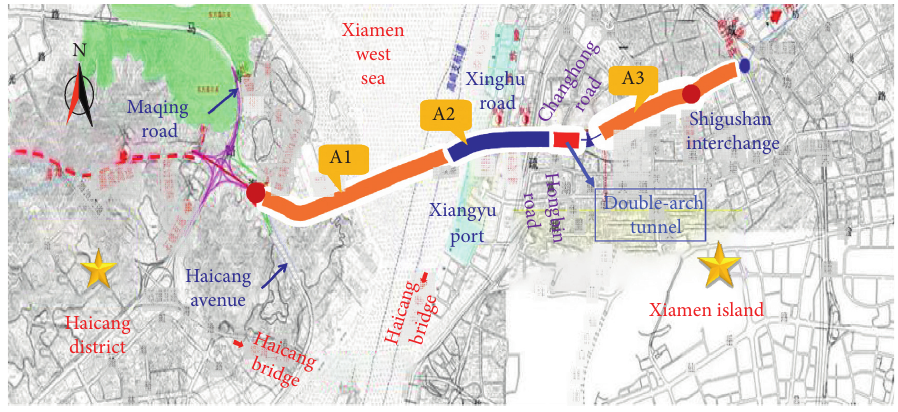
Figure 1: Plan view of the Second Western Passage project.